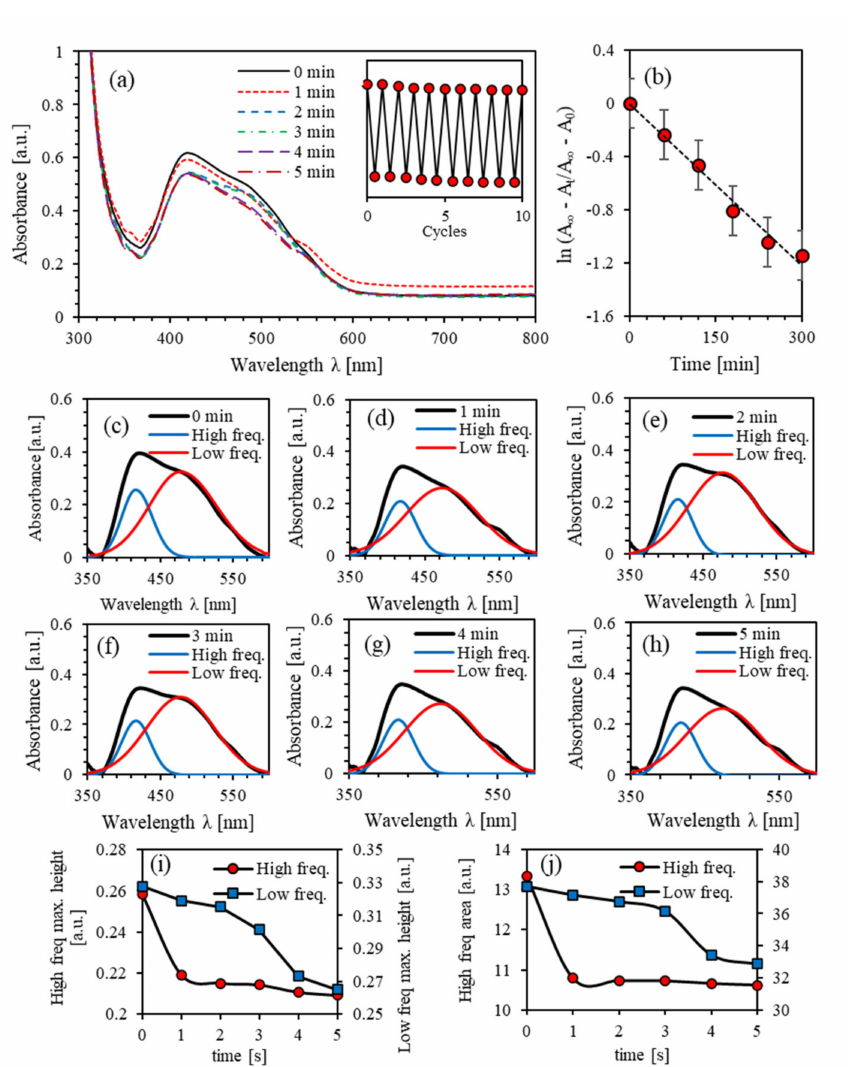
Figure 4. ( a ) Absorbance spectra of PEO-BDK-MR polymer composite thin film for various UV- illumination times, ( b ) the kinetic constants for trans → cis photoisomerization of PEO-BDK-MR polymer composite thin film, ( c – h ) Double peaks fit for the absorbance spectra of PEO-BDK-MR polymer composite thin film for various UV-illumination exposure periods of time, ( i ) The amplitude and ( j ) the integrated area-fit for the dual-peaks of the absorbance for the PEO-BDK-MR polymer composite thin film for various UV-light exposure periods of